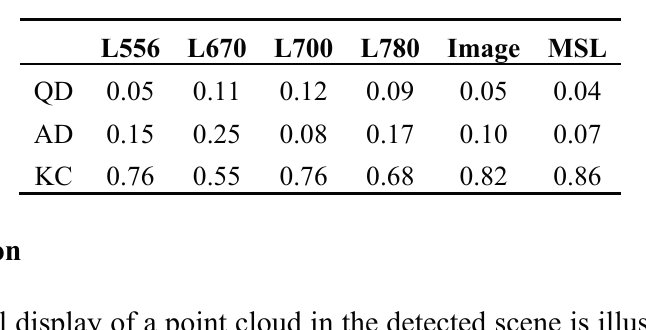
Table 2. Quantity disagreement, allocation disagreement, and kappa coefficient of SVM classification with features from L556, L670, L700, L780, multispectral image with four bands, and MSL (where QD represents the quantity disagreement as percent of domain, AD represents the allocation disagreement as percent of domain, and KC represents kappa